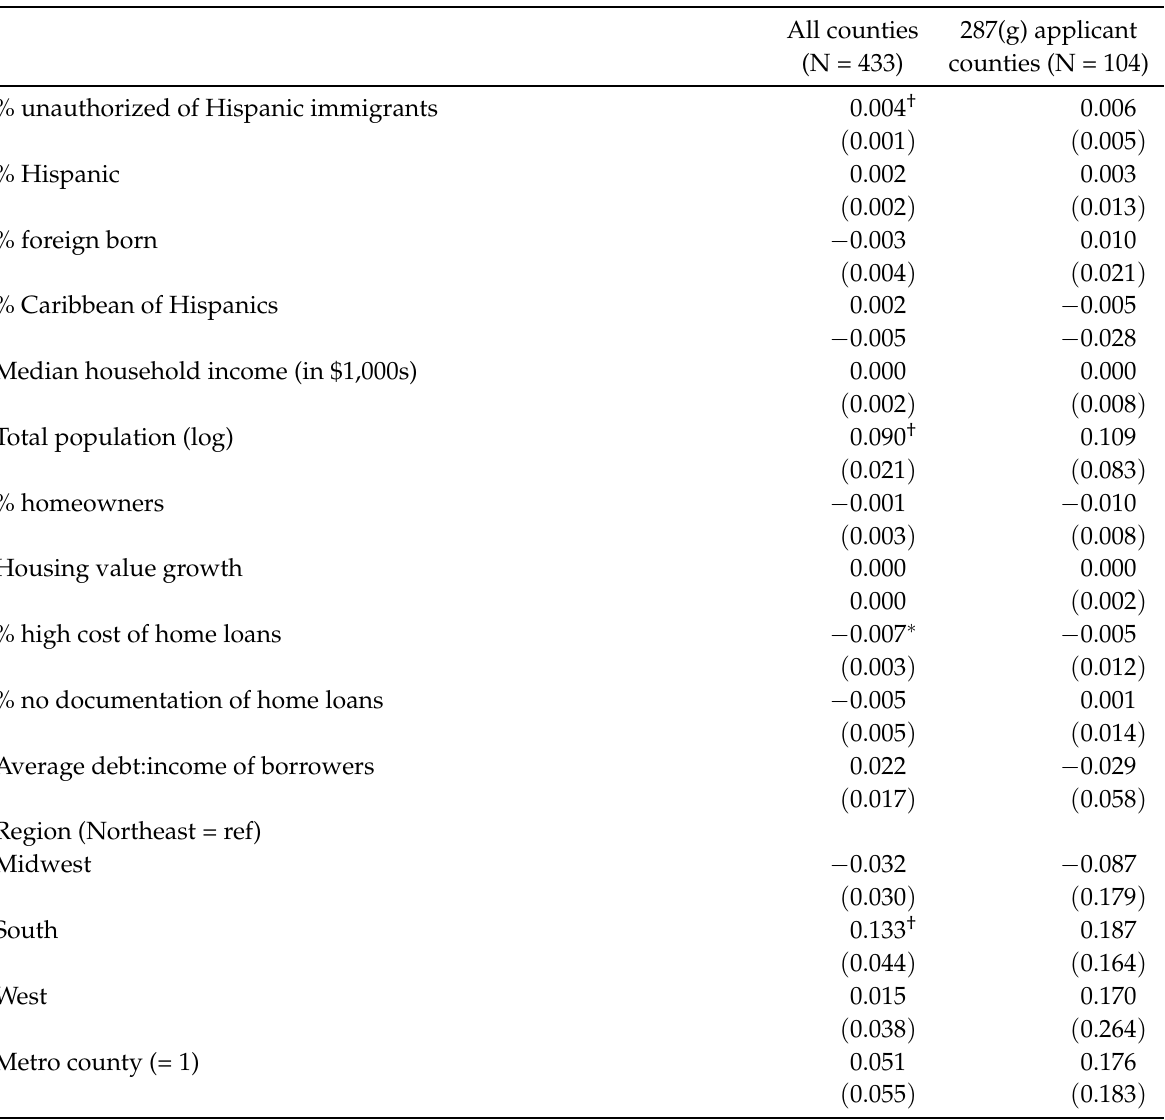
Table 1: Average marginal effects from probit of 287(g) participation.